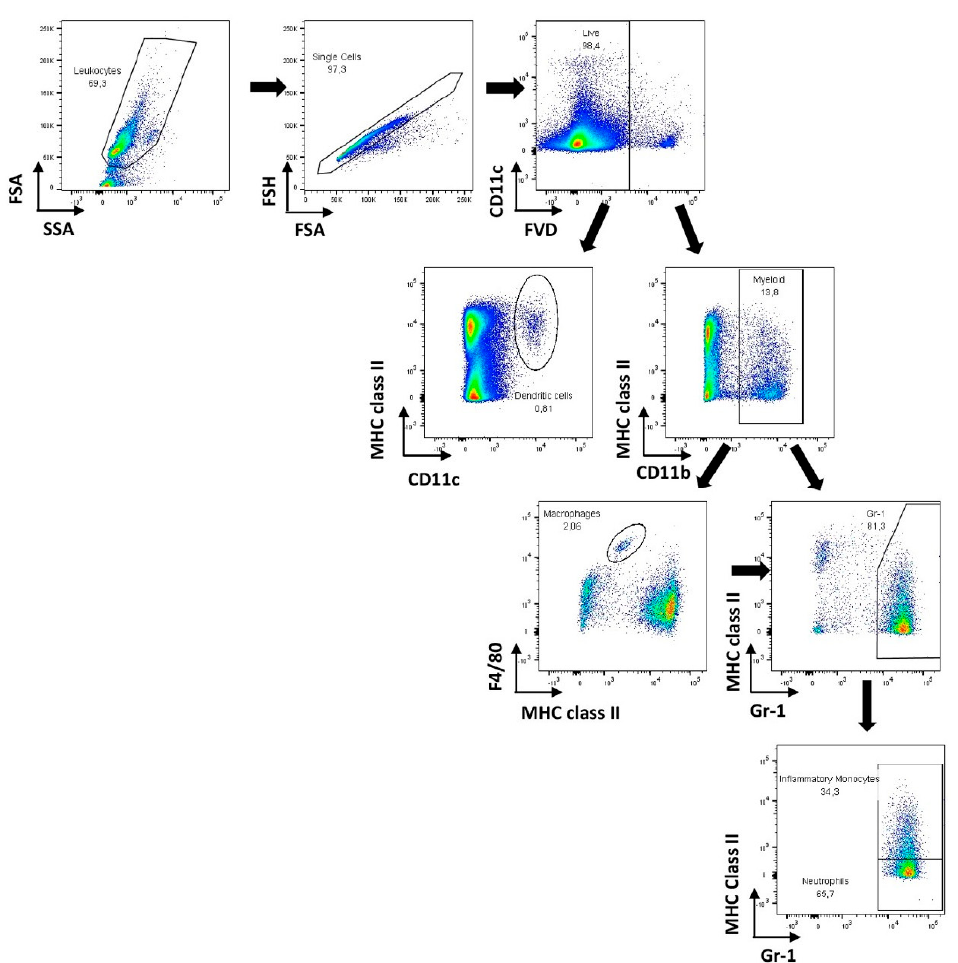
Figure 2. Gating strategy applied for the flow cytometry data analysis. Following leukocyte selection based on Forward Scatter Area (FSA) and Side Scatter Area (SSA), doublets were excluded based on FSA and Forward Scatter Height (FSH) parameters, and dead cells were further excluded by fixable viability dye (FVD) incorporation. Dendritic cells were gated as CD11c high MHC class II + cells. Myeloid cells were defined as CD11b + cells that were further divided into macrophages (CD11b + F4/80 high MHC class II low ) and Gr-1 + cells. Within the latter, neutrophils were defined as CD11b + Gr-1 + MHC class II − and inflammatory monocytes were gated as CD11b + Gr-1 + MHC class II + cells.